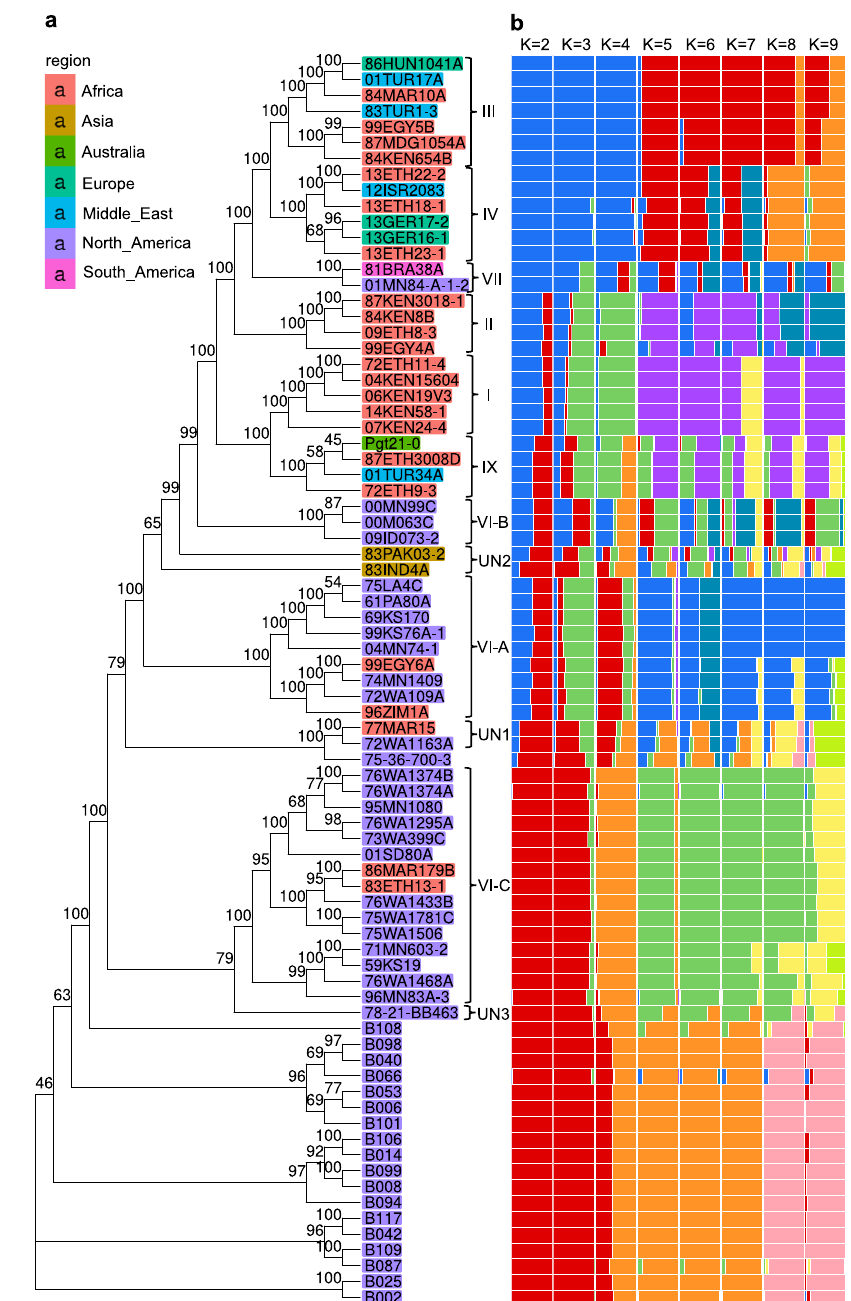
Fig. 5 | The genetic relationship and population structureofisolates in thePgt panel. a The neighbor-joining tree was constructed based on the genetic distance estimated using SNPs. The tree branch lengths are scaled to have the same length from the root to the tips and do not re fl ect the actual mutation rate along the branches. The bootstrap support values for the phylogenetic tree of the Pgt panel are shown above the branches. The previously used clade designations 34,35 are